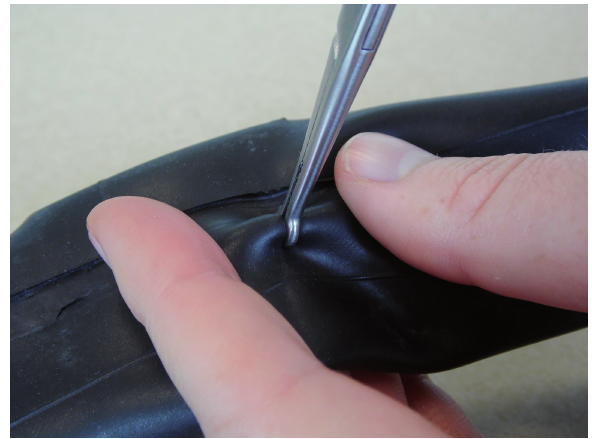
Figure 4 - The vas ring clamp around the skin, fascia, and